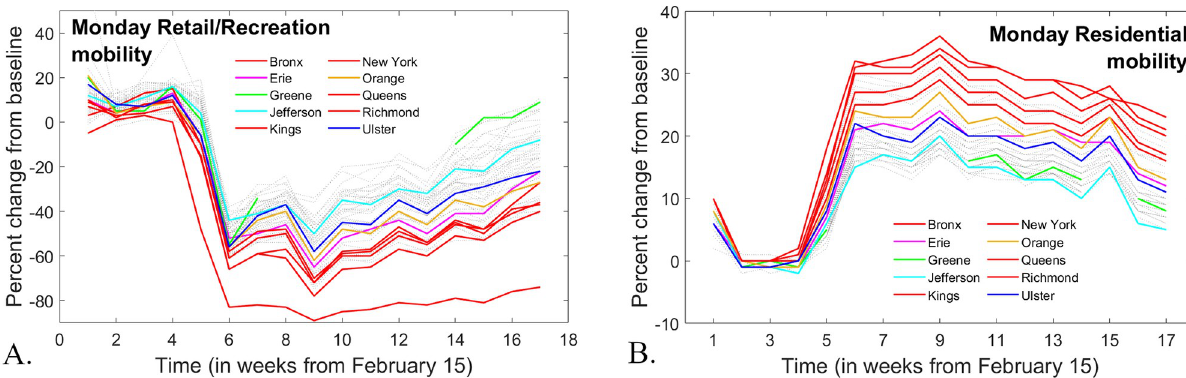
Fig 7. Weekly Monday mobility trends for all counties, as reported by Google for A. Retail and Recreation and B. Residential time .